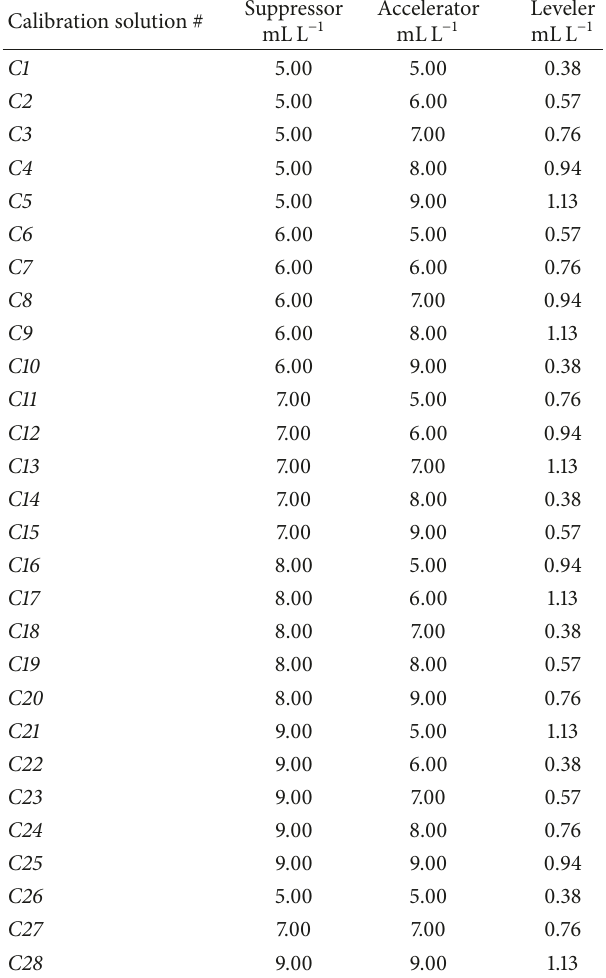
Table 1: Composition of the training set solutions.